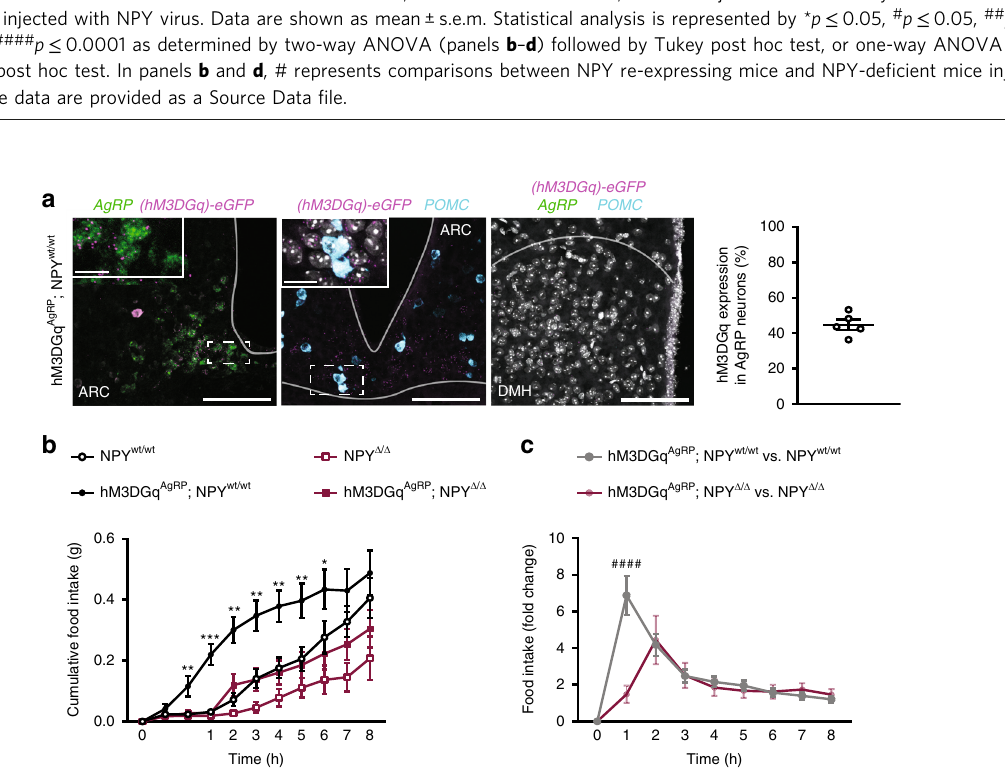
Fig. 6 NPY-dependent signaling mediates the increase in feeding as well as the induction of insulin resistance upon chemogenetic stimulation of AgRP neurons. a Expression of hM3DGq occurs exclusively in AgRP neurons of the ARC. DAPI is depicted in gray in the DMH image ( n = 5 mice). Scale bar = 100 µ m; applies to all images; scale bar = 20 µ m; applies to insets. b Food intake upon hM3DGq-induced stimulation of AgRP neurons in the presence and in the absence of NPY ( n = 10 mice for NPY wt/wt , hM3DGq AgRP ; NPY wt/wt and NPY Δ / Δ , and n = 11 mice for hM3DGq AgRP ; NPY Δ / Δ ). c NPY is necessary for the acute food consumption upon AgRP neuron stimulation ( n = 10 mice for NPY wt/wt , hM3DGq AgRP ; NPY wt/wt and NPY Δ / Δ , and n = 11 mice for hM3DGq AgRP ; NPY Δ / Δ ). All animals were injected with CNO. Data are shown as mean ± s.e.m. Statistical analysis is represented by * p ≤ 0.05, ** p ≤ 0.01, *** p ≤ 0.001, and #### p ≤ 0.0001 as determined by two-way ANOVA followed by Tukey post hoc test, except for panel c where a Sidak post hoc test was performed. # represents comparisons between NPY-expressing and NPY-de fi cient animals. Source data are provided as a Source Data fi